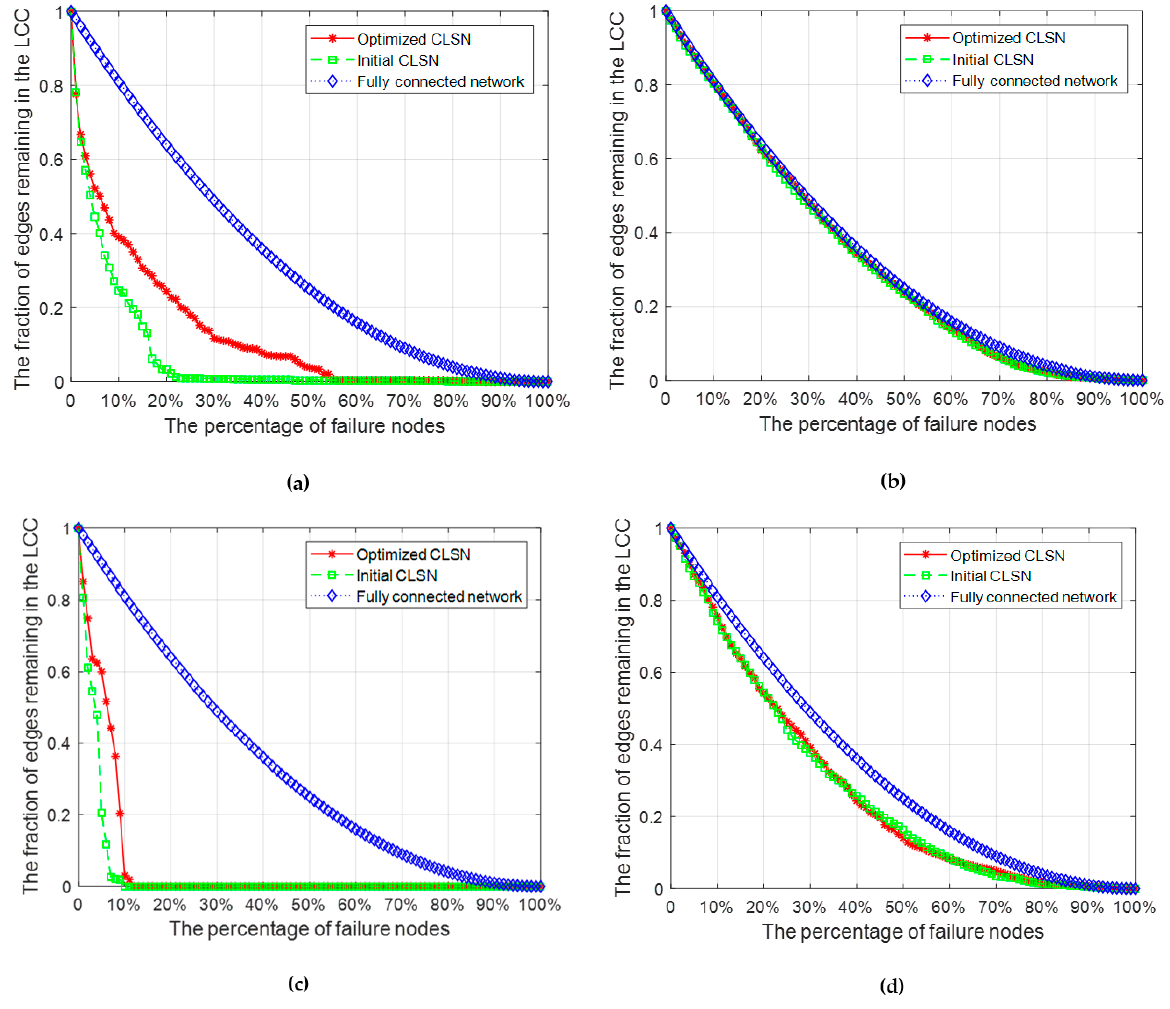
Figure 7. Comparison of robustness before and after application of the MPEA-RSN algorithm. ( a ) A closed-loop supply network (CLSN) based on the generated SN under malicious attacks. ( b ) CLSN based on the generated SN under random attacks. ( c ) CLSN based on a realistic SN under malicious attacks. ( d ) CLSN based on a realistic SN under random attacks.